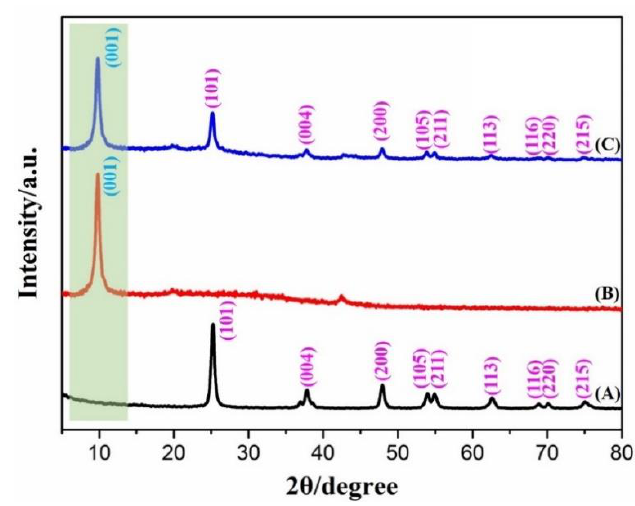
Figure 2. XRD patterns of TiO 2 NPs ( A ), graphene oxide (GO) nanosheets ( B ), and TiO 2 /GO nanohybrids ( C ).